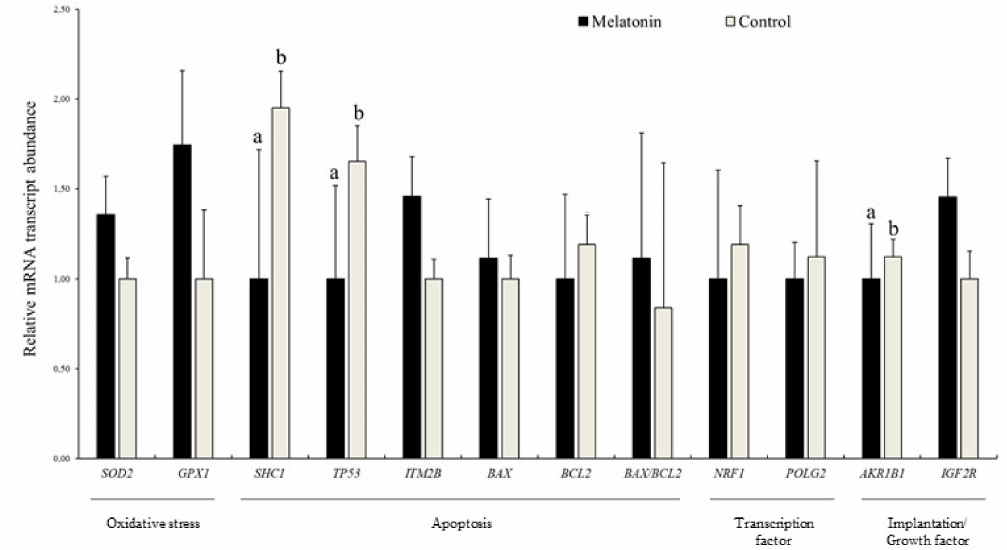
Figure 9. Relative mRNA transcript abundance in Iberia red deer blastocysts produced in vitro from ovary stored with (Melatonin) and without melatonin (Control); Results are expressed as mean ± SEM; a,b Di ff erent letters indicate di ff erences ( p ≤ 0.05) among